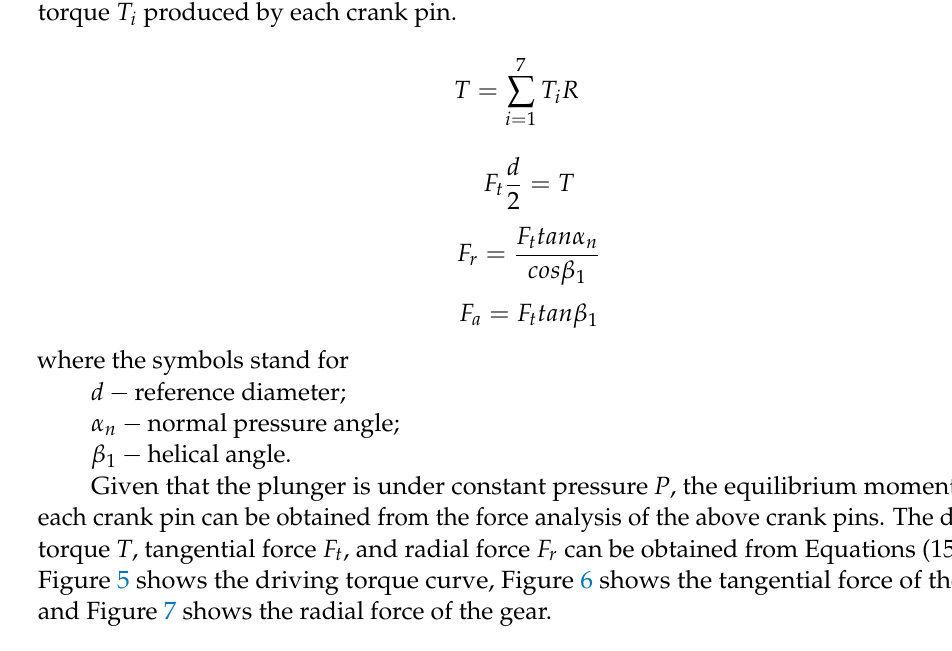
Figure 5. Diagram of the crankshaft driving torque. T / ( k N × m )